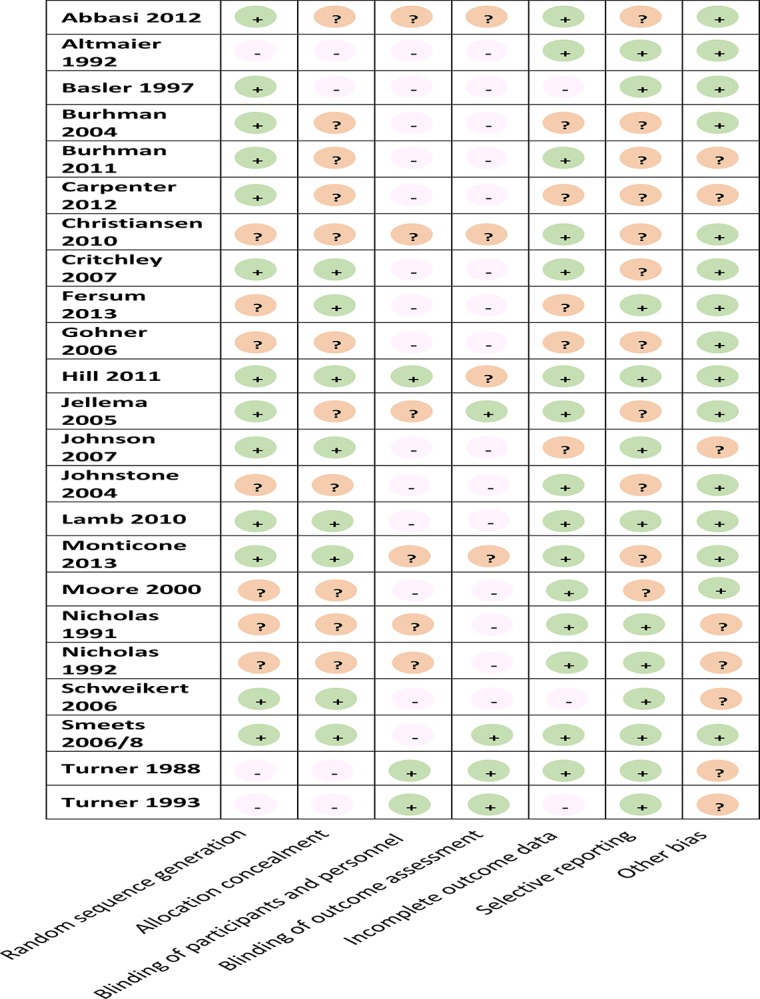
Risk of bias of included studies.